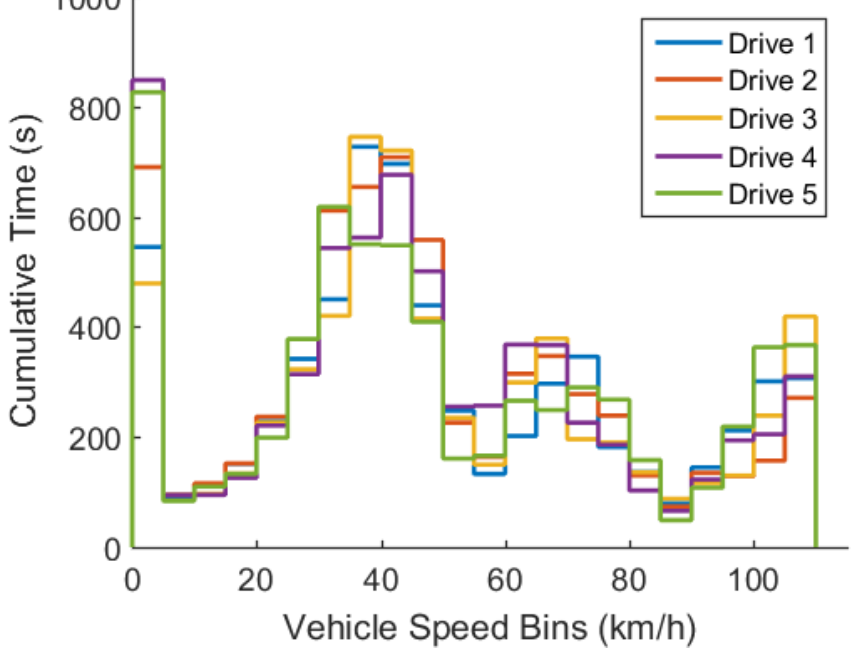
Figure 7. Vehicle speed residency across each drive with respect to